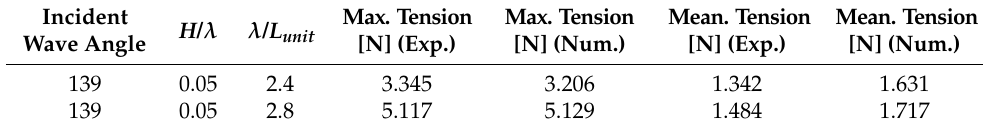
Figure 28. Time series data of total tension under oblique sea: ( a ) 𝝀/𝑳 𝒖𝒏𝒊𝒕 = 2.4; ( b ) 𝝀/𝑳 𝒖𝒏𝒊𝒕 = 2.8.